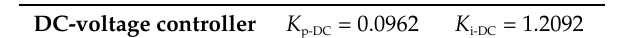
Table 2. Control parameters.